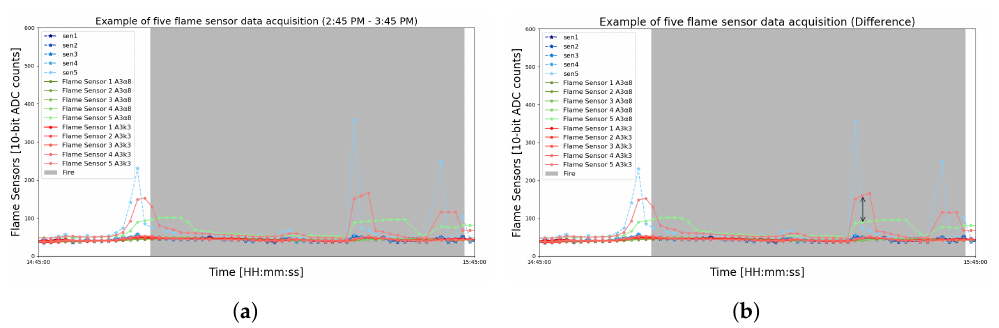
Figure 9. Zoomed plotting of the sensor module’s flames data that illustrates the difference proposed by approach A 3 through α n = 8 and kn = 3. ( a ) The raw and smoothed flame sensor during a fire test. ( b ) Black arrow with unknown D size marking the difference between raw and both smoothed